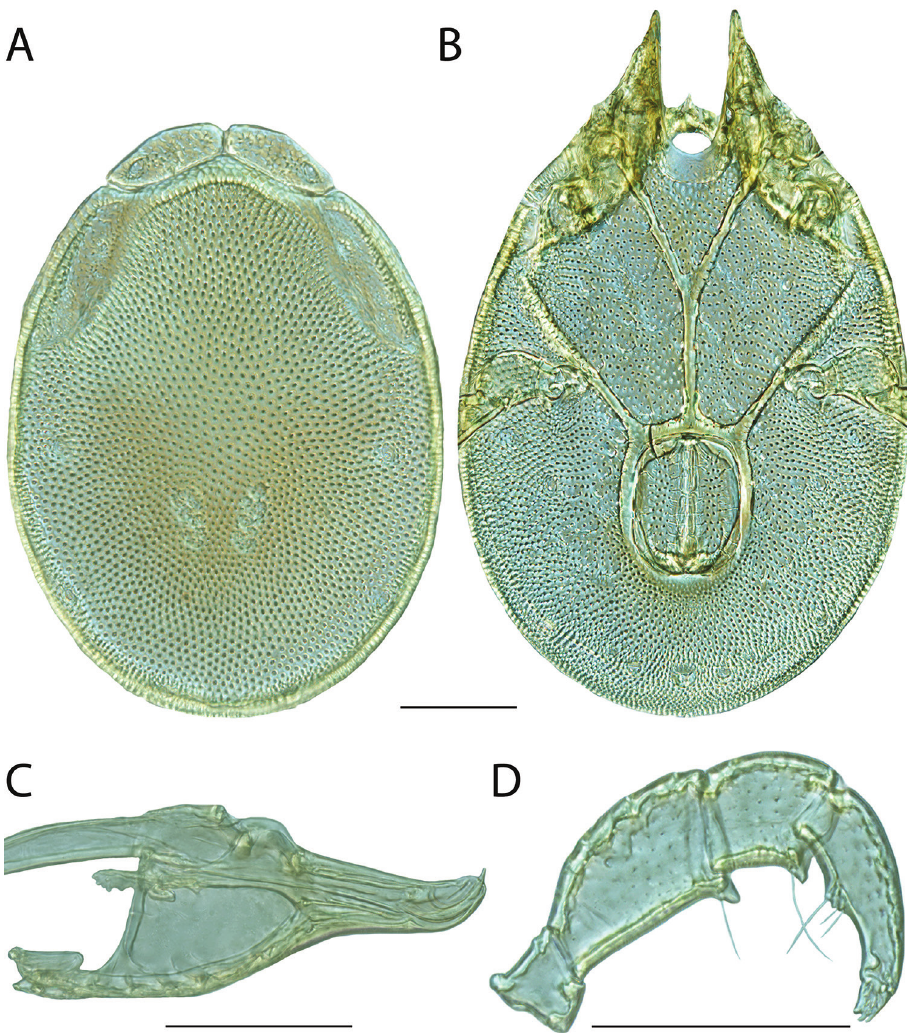
Figure 169. Torrenticola nortoni sp. n. male: A dorsal plates B venter (legs removed) C subcapitulum D pedipalp (setae not accurately depicted). Scale = 100